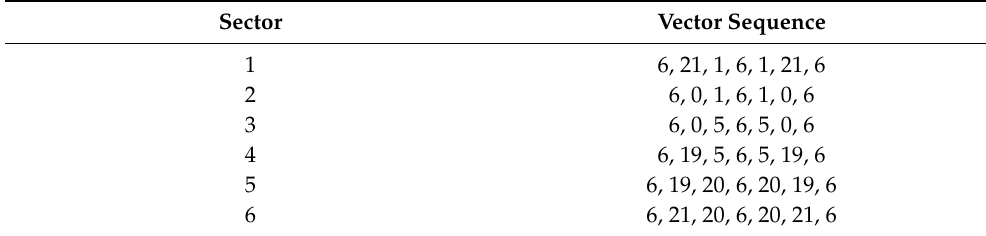
Table A7. Vector switching sequences of the sixth outer hexagon, by the ith designation (V i ).